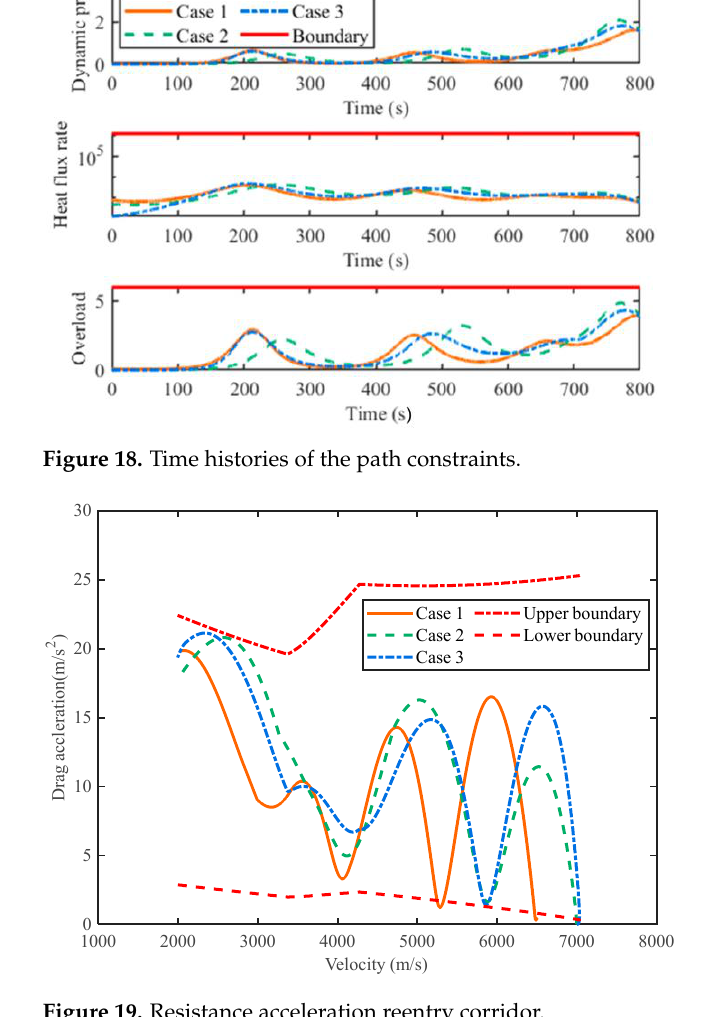
Figure 20. Velocity histories of the AOA. Figure 21. Velocity histories of the bank angle.